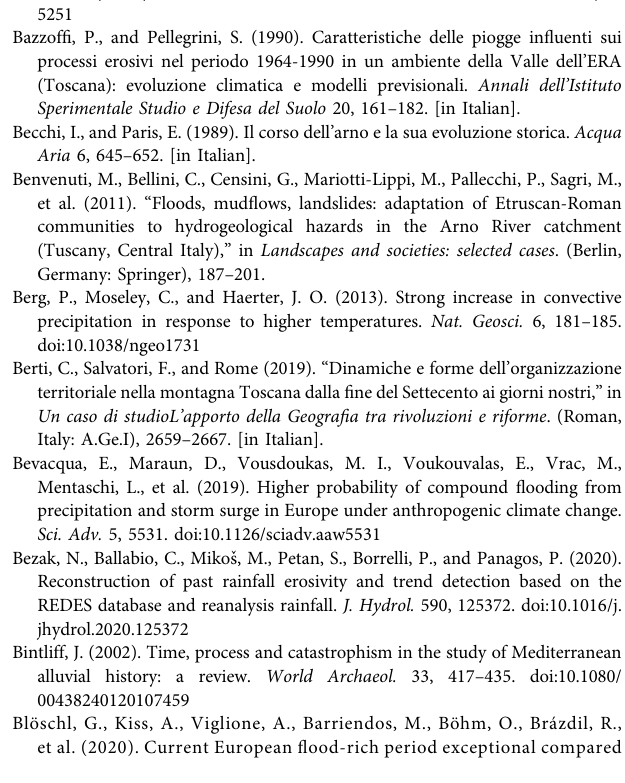
( Figure 7E ) is available at https://doi.pangaea.de/10.1594/ PANGAEA.921916. Areal mean of annual precipitation for the Arno River Basin was retrieved from the